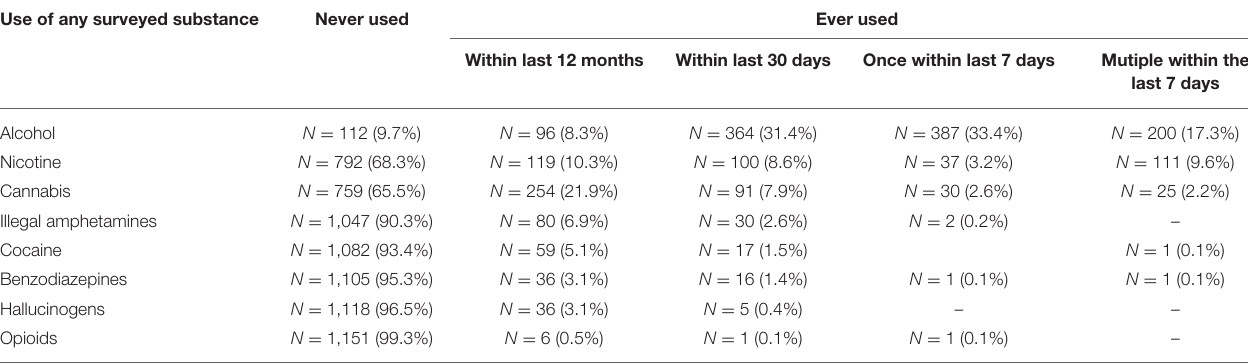
TABLE 3 | Use of psychoactive substances explicitly NOT for PN. Use of any surveyed substance